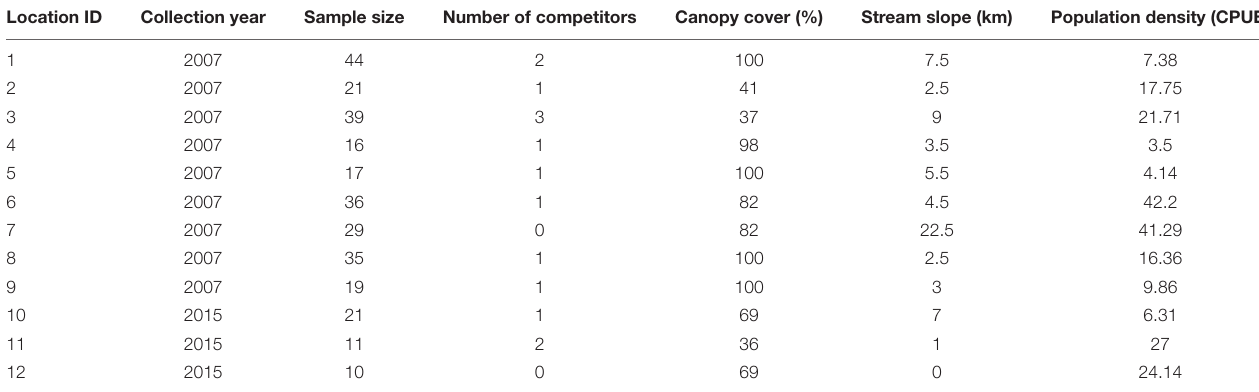
TABLE 2 | Sample size, selective agents, and collection year for all twelve locations in the study.